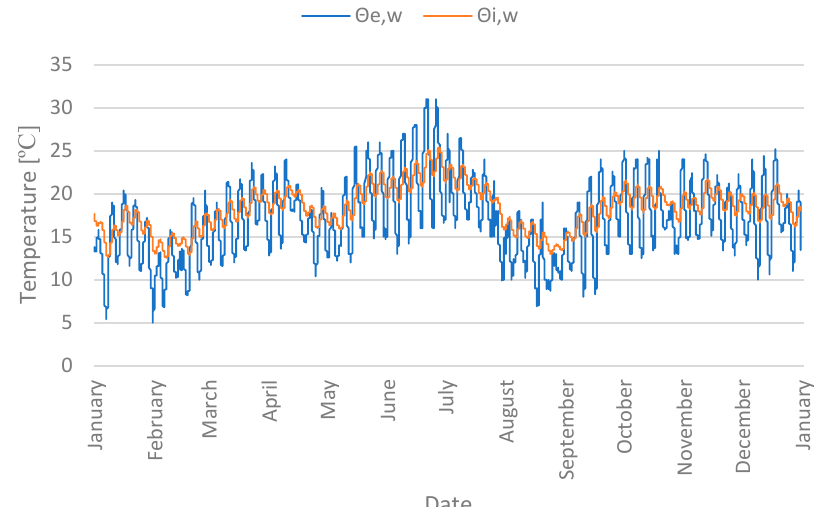
Figure 7. Temperature course of internal ( Θ i,w ) and external ( Θ e,w ) air in an unheated church with a wooden floor.